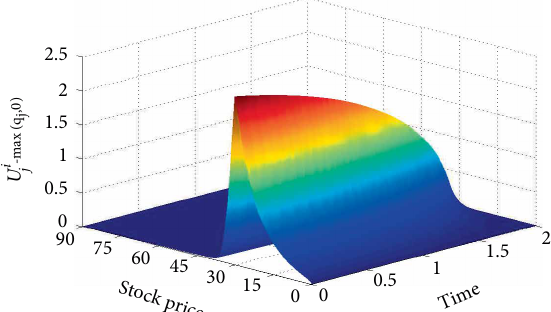
with Figure 2: Mesh surface of 𝑟 = 0.05, 𝛾 = 0.06, 𝑈(𝑧,𝑡) − 𝑞(𝑧) .